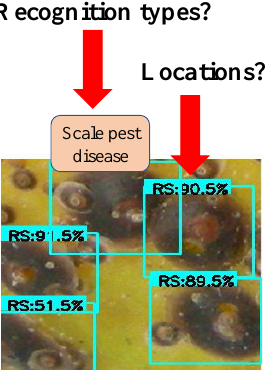
Figure 1. Predicting the types and locations of the scale pests appearing in the image.